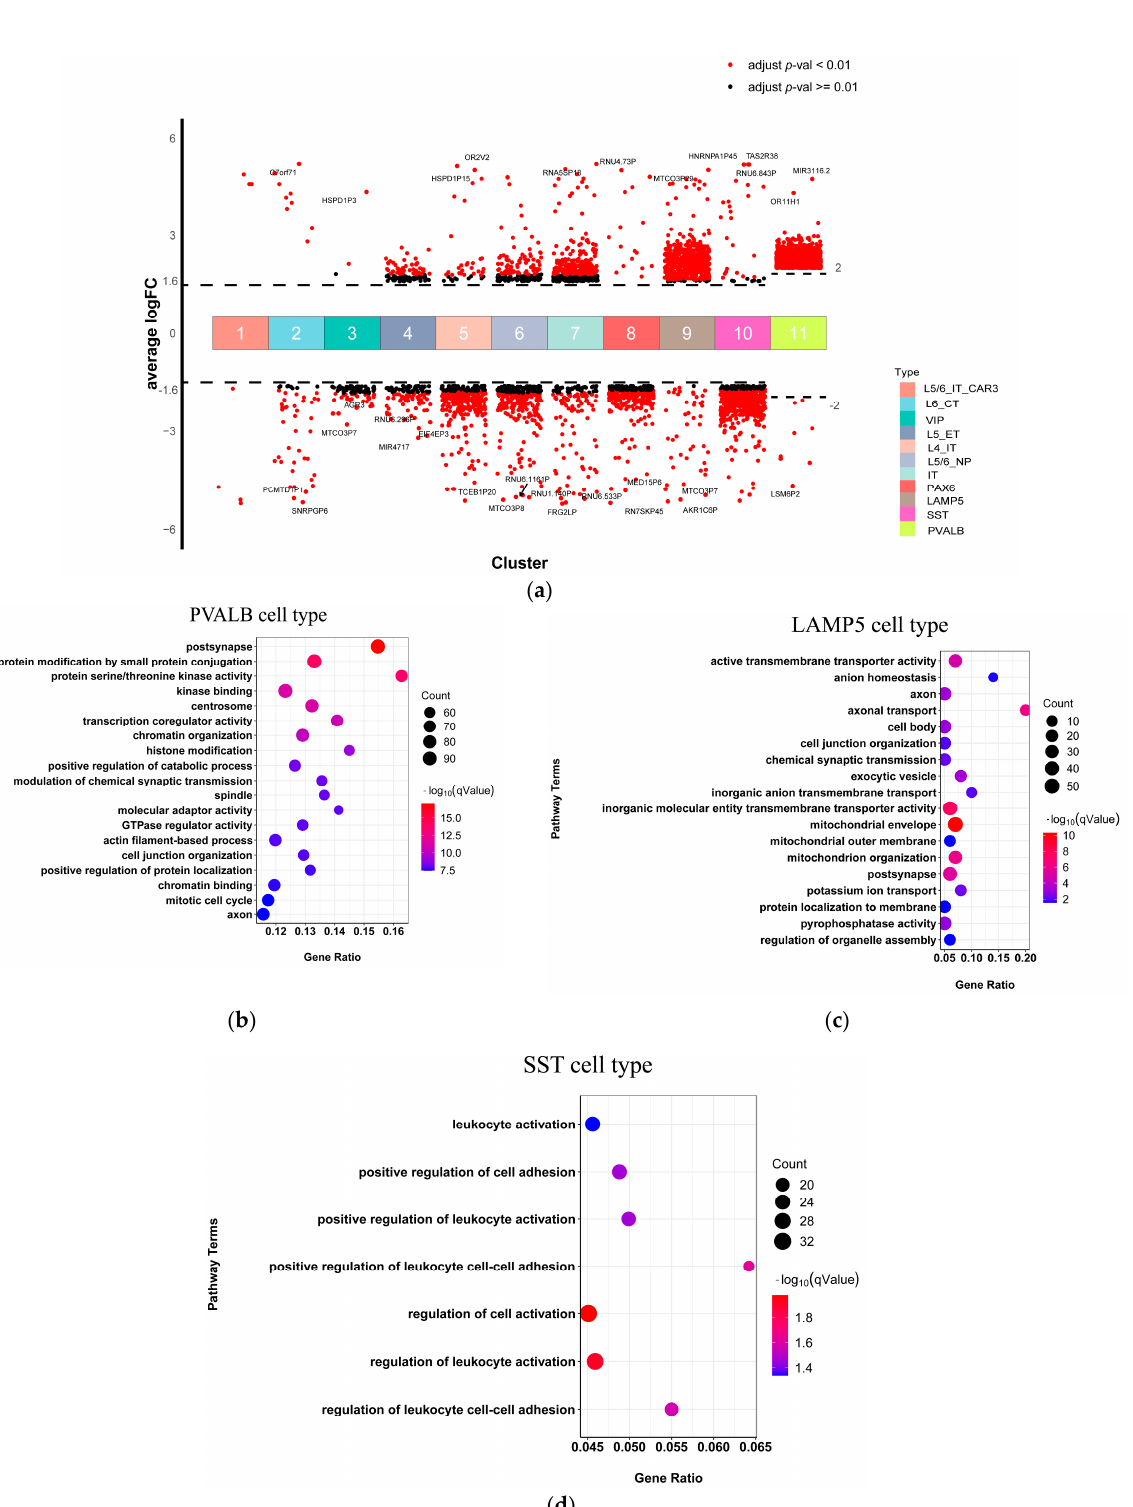
Figure 3. Neuronal type-special DEGs and related pathways of scRNA-seq. ( a ) Differential gene expression analysis showing up- and down-regulated genes across all 11 neuronal clusters. An adjusted p -value < 0.01 is indicated in red, while an adjusted p -value ≥ 0.01 is indicated in black; ( b – d ) The top significantly overrepresented GO terms. The x-axis represents the gene ratio. The y-axis indicates the items of GO, the color of dots represents the value of -log (FDR adjusted p -value), and the size of dots represents the count of genes.